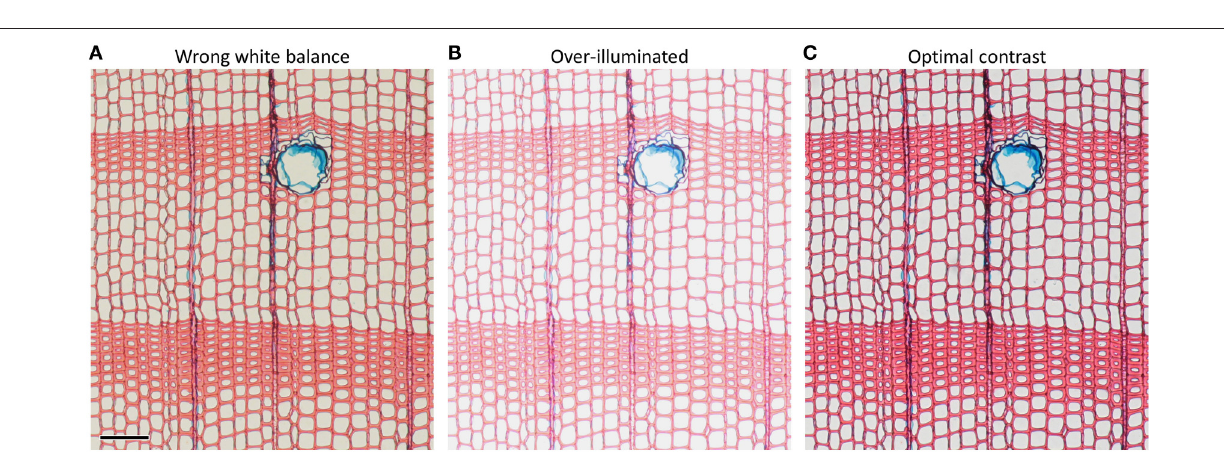
FIGURE 5 | Image of a slide with some pollution as indicated by yellow arrows (A) before and (B) after cleaning ( Pinus sylvestris ). Scale bar = 100 µ m.